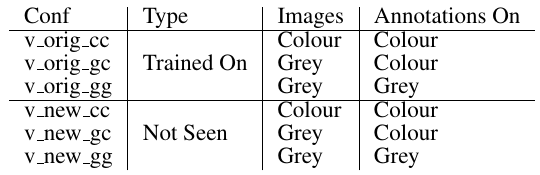
Table 2. Configurations for the Validation Sets the different networks were trained